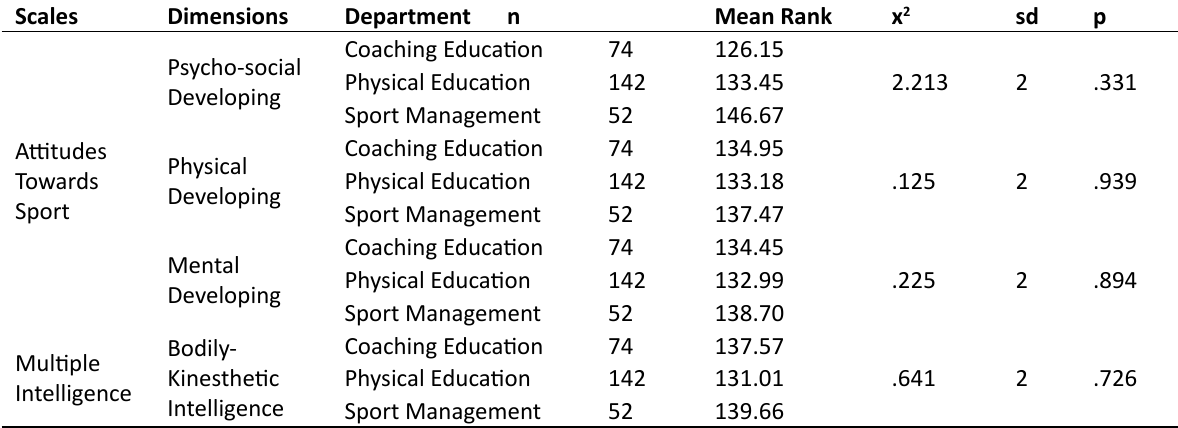
Table 5. Evaluation of the students’ attitudes towards sport and bodily-kinesthetic intelligence by department.